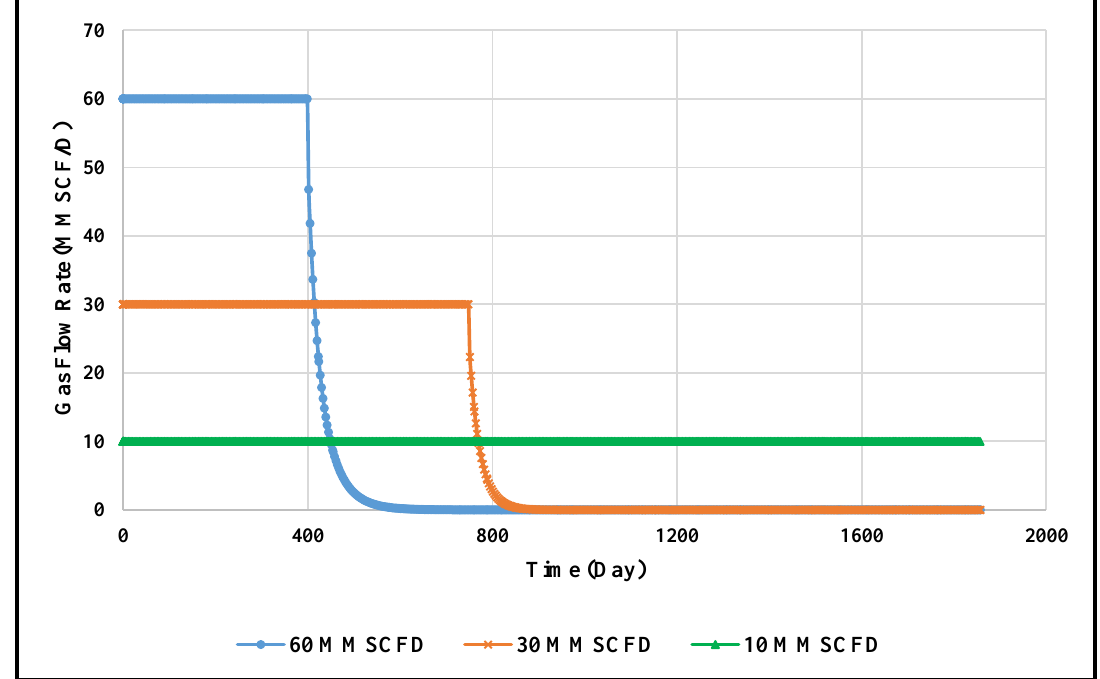
Figure 15. Profiles of gas production for various gas-flow rates.